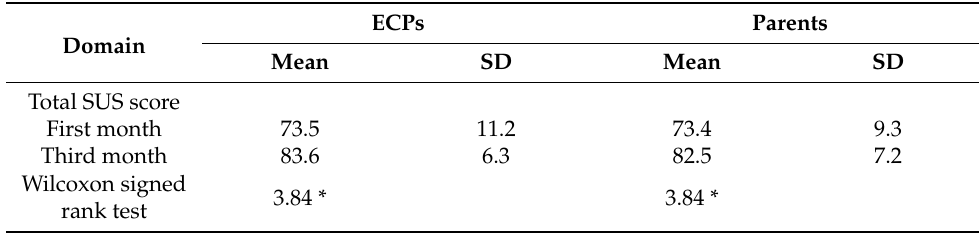
Table 5. System Usability Scale (SUS)